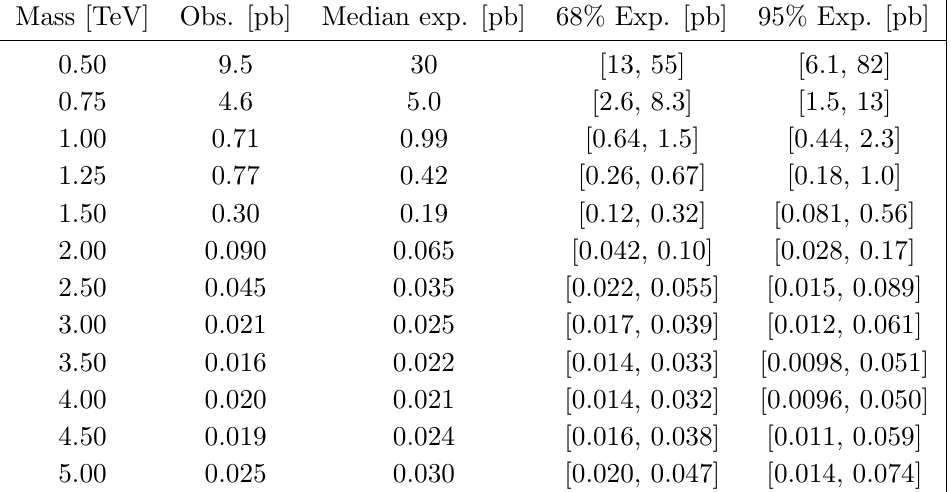
Table 5 . Limits at 95% CL on the product of the resonance production cross section and branching fraction for the g KK gluon resonance